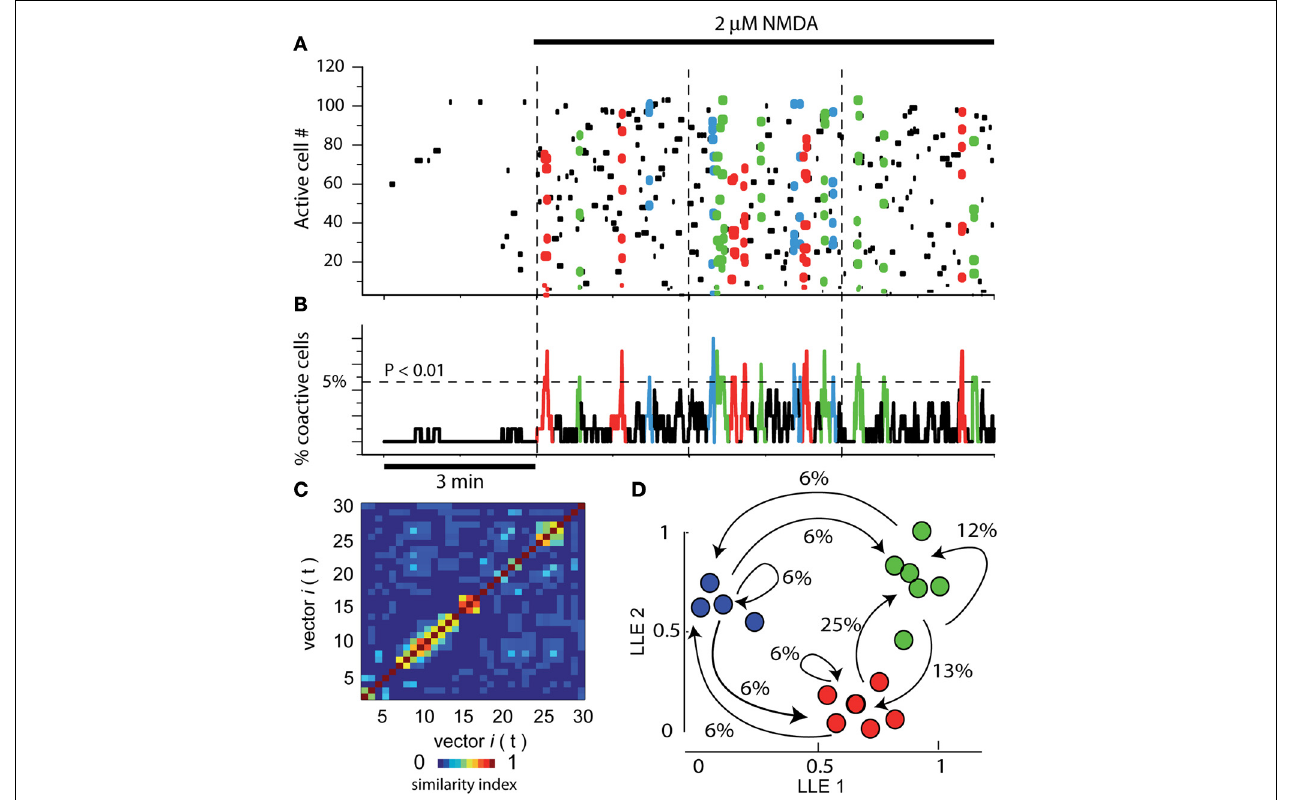
FIGURE 1 | Assembly dynamics in the control striatal circuitry after NMDA. (A) Raster plot showing the simultaneous activity of > 100 neurons in a striatal slice using calcium-imaging. Each row in the matrix represents the activity of a single neuron across the series of images (columns). Left epoch shows 3min of activity in control striatal tissue without NMDA. Note scarce activity and the absence of peaks of synchronization. In the next three epochs, separated by dashed vertical lines, 9min of activity are shown after adding 2 μ M NMDA into the bath saline (denoted by horizontal black line on top). Note that many more dots, some of them colored, populate the matrix. Colored dots denote the synchronized activity of several neurons in a given column or neighboring columns (a neuron pool is then represented as a column vector). Note that different neuron pools produce the circuit activity along time. (B) Activity histogram at bottom is the summed neuronal activity (multicellular activity) from the raster plot above column by column (frame by frame in a given movie). The dashed line